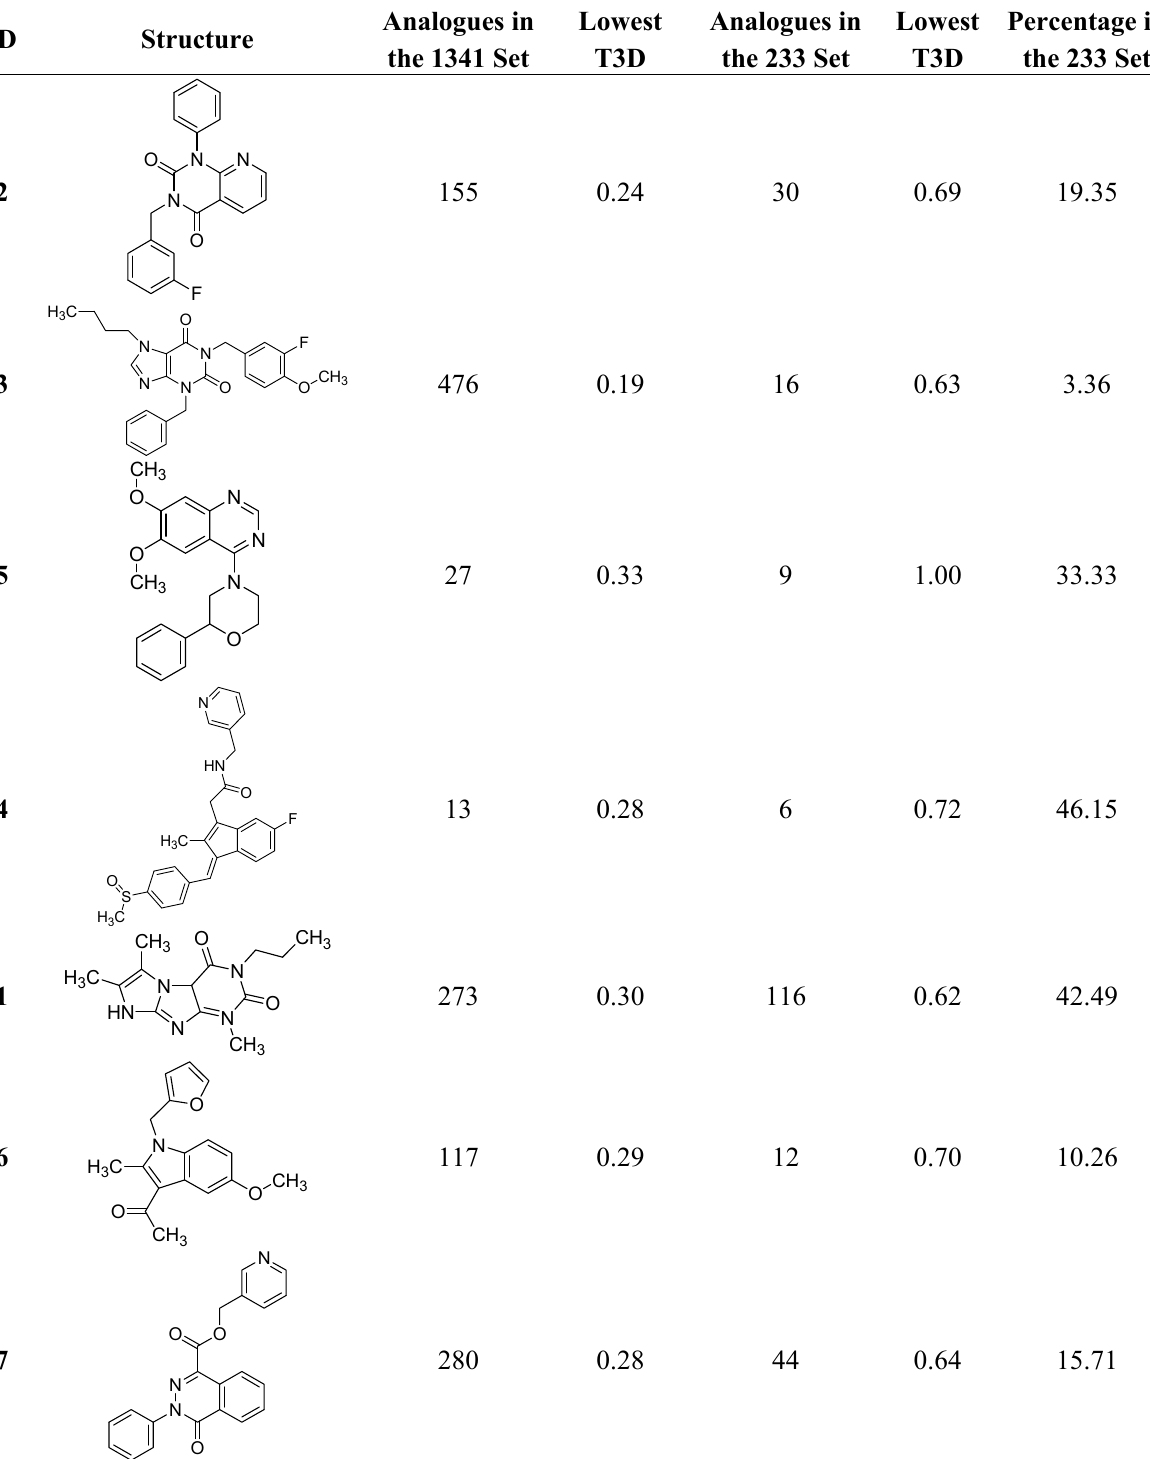
Table 3. Distribution of the T3D values in the entire second round selection library and within the library having fusion score above